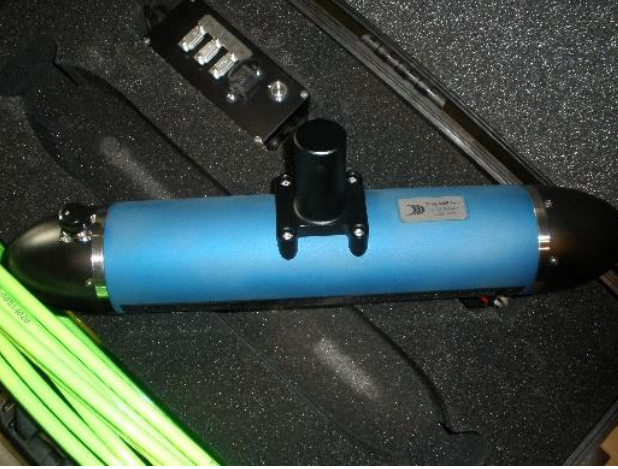
Figure 1. Photograph of the 3D Sidescan 3DSS-DX-450 sonar system (photograph: A. Stateczny).